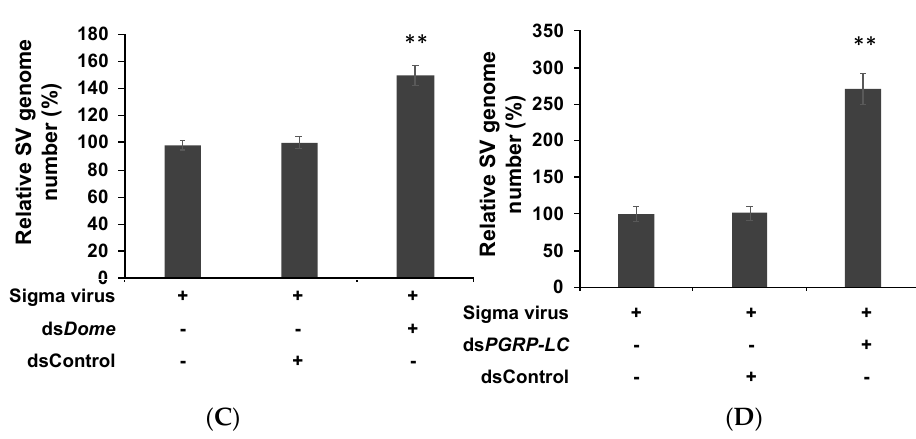
Figure 2. Sigma virus (SV) genome copy number increased after knocking down PGRP-LC and dome . RT-qPCR showed that dsRNA can efficiently suppress domeless ( A ) or PGRP-LC ( B ) expression in S2 cells at 2 dpt. “-”: without dsRNA transfection; “Control”: S2 cells transfected with dsControl. The viral genome replication of the sigma virus was detectable by RT-qPCR after knocking down domeless ( C ) or PGRP-LC ( D ) using dsRNA. dsControl was used as the negative control. We set the dsControl group as 100% expression. A dsRNA targeting the GFP gene was used as the negative control and designated dsControl. The mean and SD shown are shown. ** p < 0.005, one-sample t -test. All experiments were performed with three biological